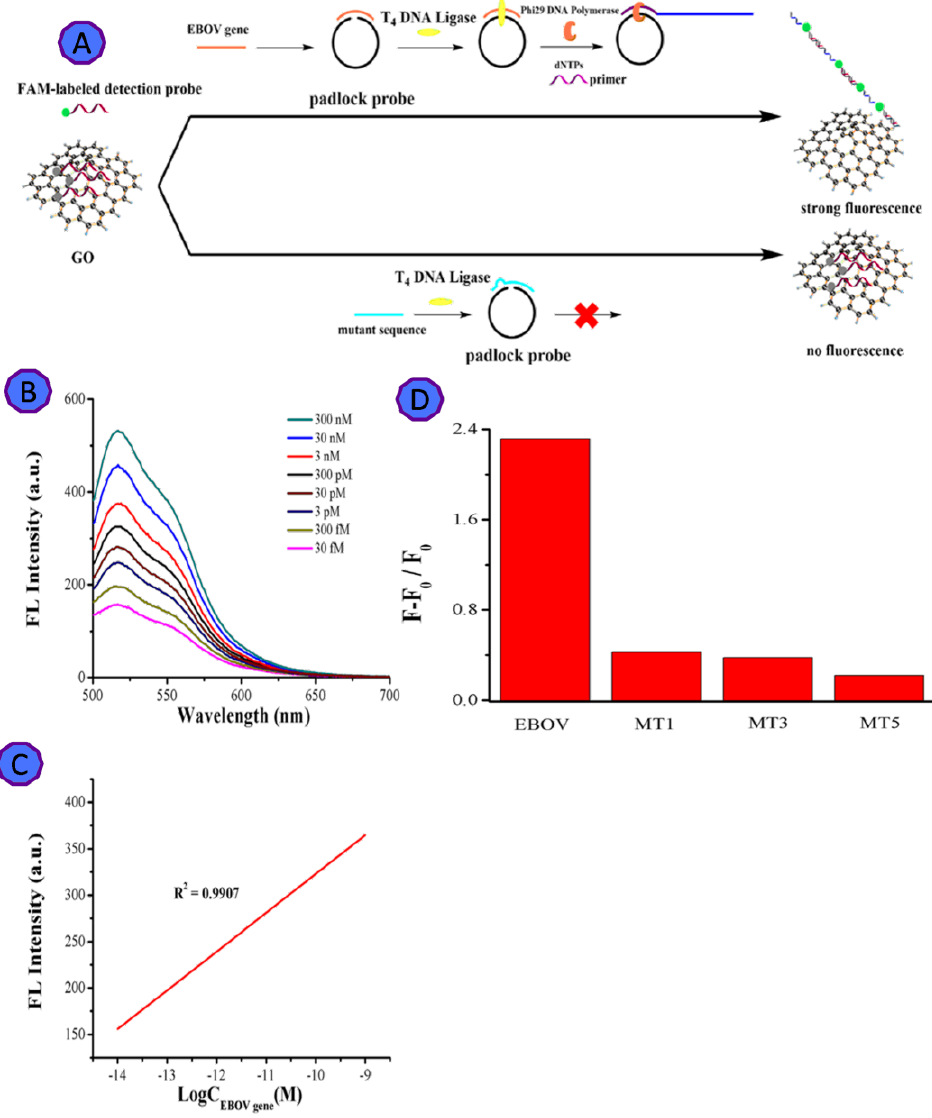
Figure 4. ( A ) The graphical representation shows the GO-assisted amplified biosensor for EBOV detection; ( B ) fluorescence increase as a function of virus increase; ( C ) the relationship between flu- orescent intensity and the concentration of EBOV gene; ( D ) the relationship between the (F − F 0 )/F 0 of GO and EBOV gene, with single-base mismatched sequence (MT1), three-base mismatched se- quence (MT3), and five-base mismatched sequence (MT5). Reprinted with permission from Ref. [67]. Copyright 2022, Elsevier B.V.